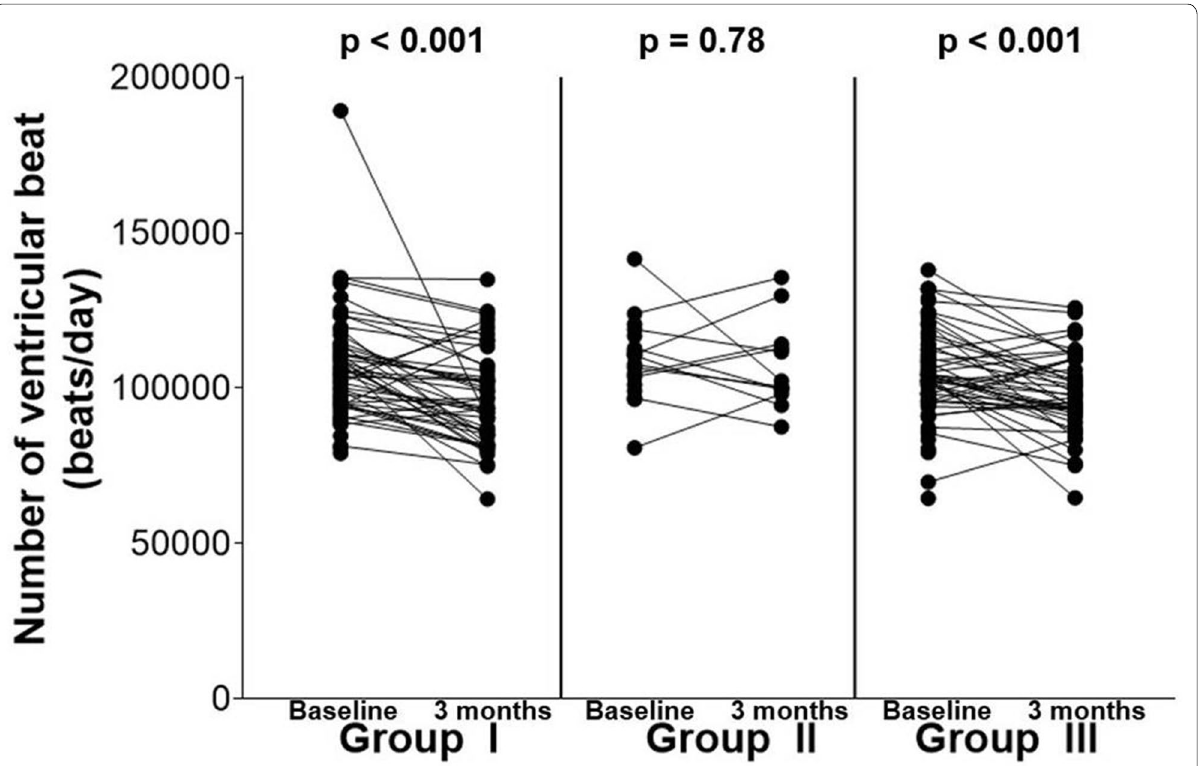
Fig. 3 Changes in the number total ventricular beats after β‑blocker treatment according to groups. The number of total ventricular beats was significantly reduced in patients of Group I and Group III, whereas there was no significant change in patients of Group